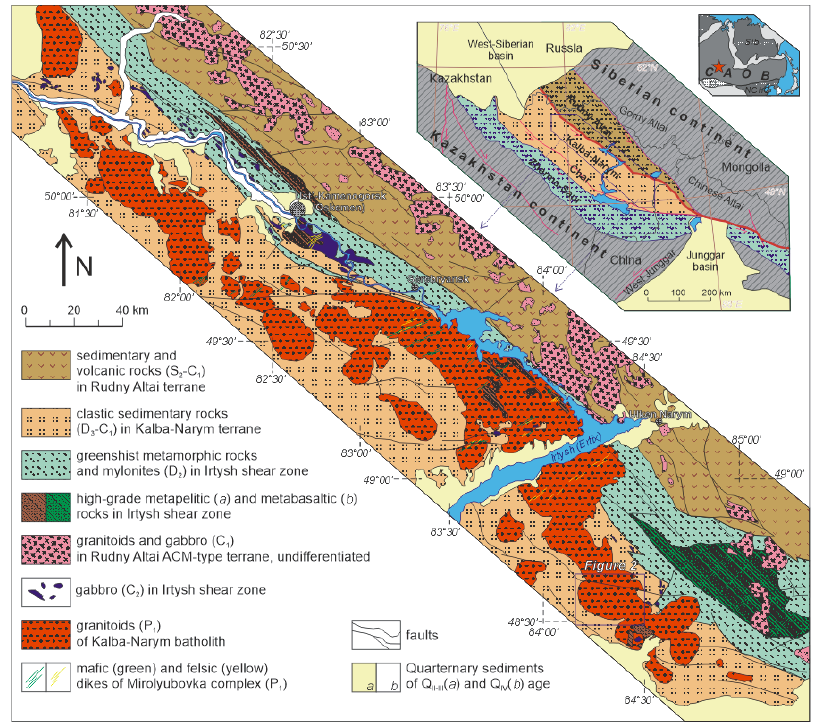
Figure 1. Geological map of the Kalba–Narym batholith in eastern Kazakhstan.